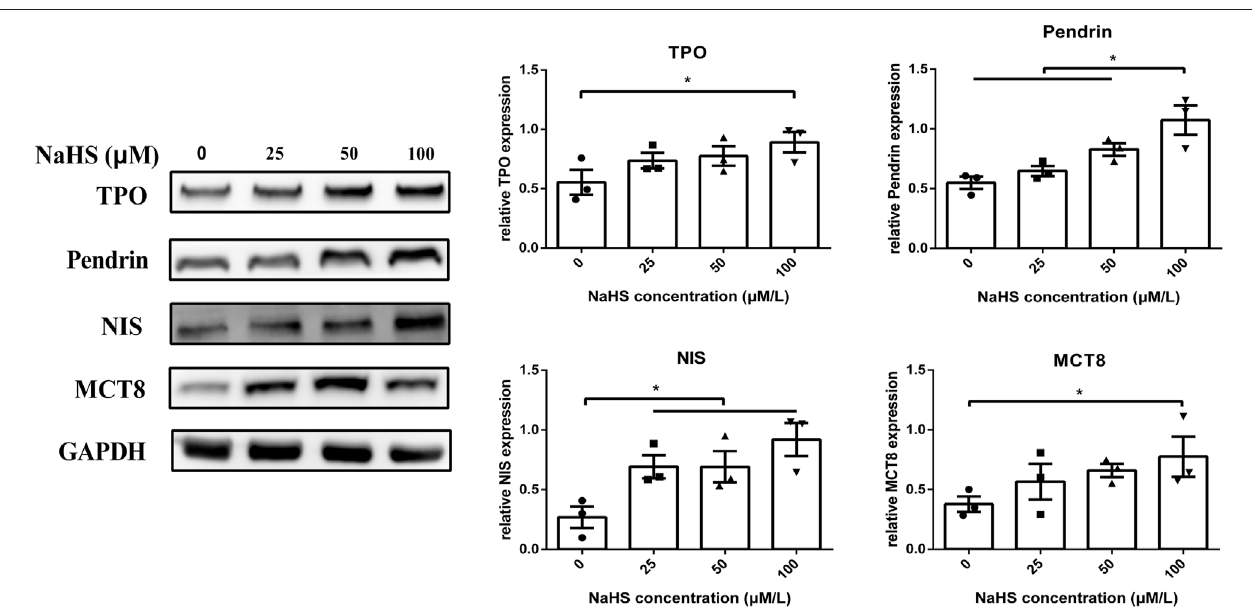
FIGURE 4 | Effect of H 2 S on thyroid hormone synthesis- and secretion-related molecules in human primary thyrocytes. Changes in TPO, Pendrin, NIS, and MCT8 expression in human primary thyrocytestreated with different concentrations ofNaHS by Westernblot. They were upregulated in a concentration-dependent manner in NaHS.* p < .05,TPO:thyroidperoxidase,NIS:sodium/iodide symporter, MCT8:monocarboxylate transportereight;NaHS, sodium hydrosul fi de. Dataareexpressed as the mean ± SEM, and all experiments were performed independently three times.